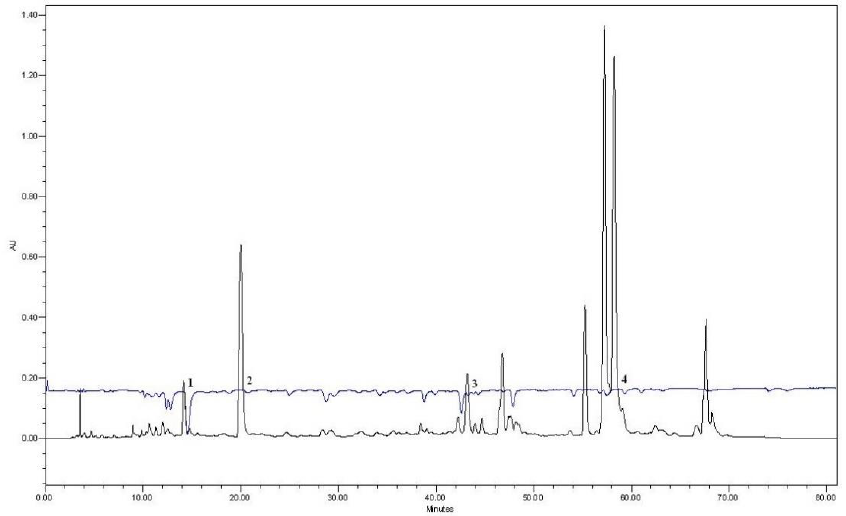
Figure 3. HPLC chromatogram of 30% aqueous PEG400 balsam poplar buds extract combined with their respective post-column ABTS chromatogram which presented as negative peaks (1 — caffeic acid, 2 — p -coumaric acid, 3 — cinnamic acid, 4 — galangin).